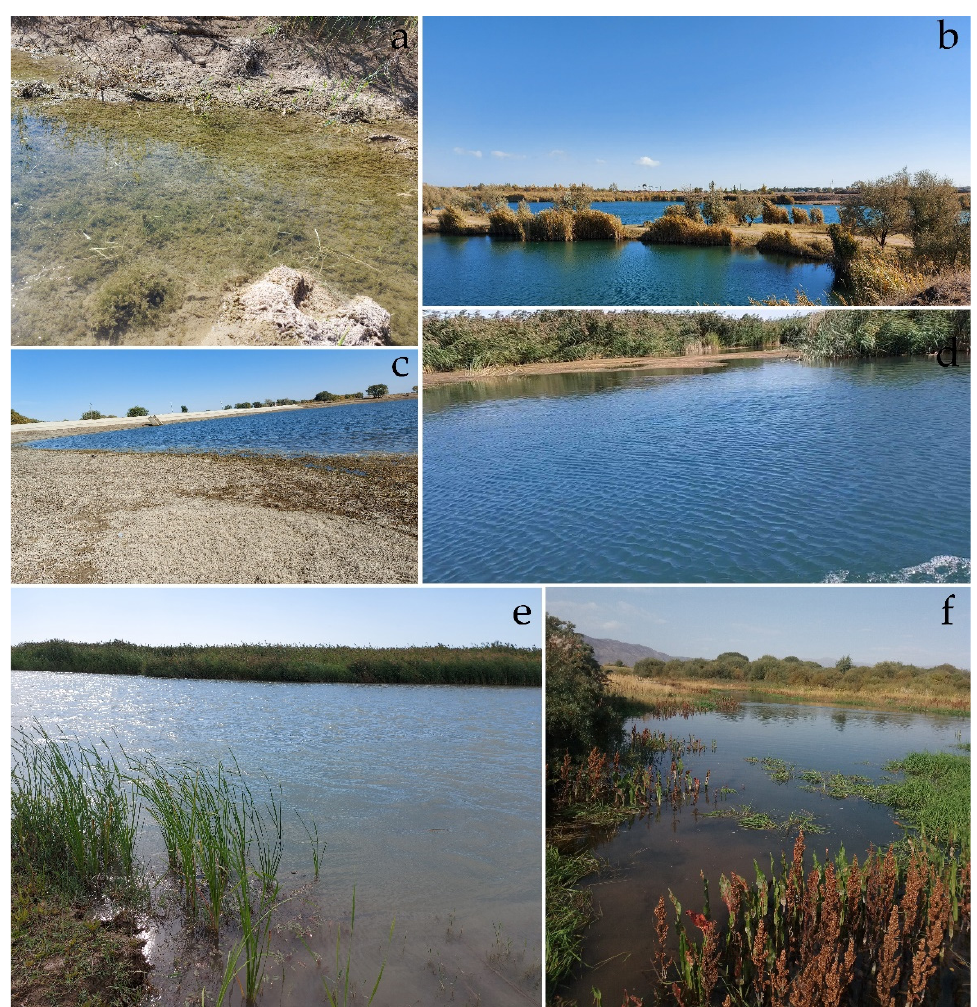
Figure A1. Sites view of investigated points in south and southeast Kazakhstan which are harboring charophyte populations, 2019–2022: the Karabalta River, Chara vulgaris ( a ); the Kaskelen River pond 1, C. kirghisorum ( b ); the Ostemir pond, C. globata ( c ); the Canal Arystan of the Ili River, C. dominii , Nitellopsis obtusa ( d ); the Ili River, Canal Zhidely, C. contraria , C. dominii , C. vulgaris ( e ); the Ulken- Kokpak River, C. contraria ( f ). 1. Chara aspera Willdenow var. aspera Description: The plants are dioecious with triplostichous, isostichous to tylacan- thous, stem cortex, solitary acute spine cells, acuminate stipulodes in 2 well developed rows, solitary gametangia (Figure A2b). Specimens: Canal Dostyk ( АА 1-1); Syrdarya River ( АА 2-1); Kaskelen River pond 1 ( АА 26-1); Lake Alakol 1 ( АА 52-1); June, August, and October (Figure 1c). Habitat: both fresh and brackish waters; 4 sites; lakes, large ponds, canals, and rivers. 2.